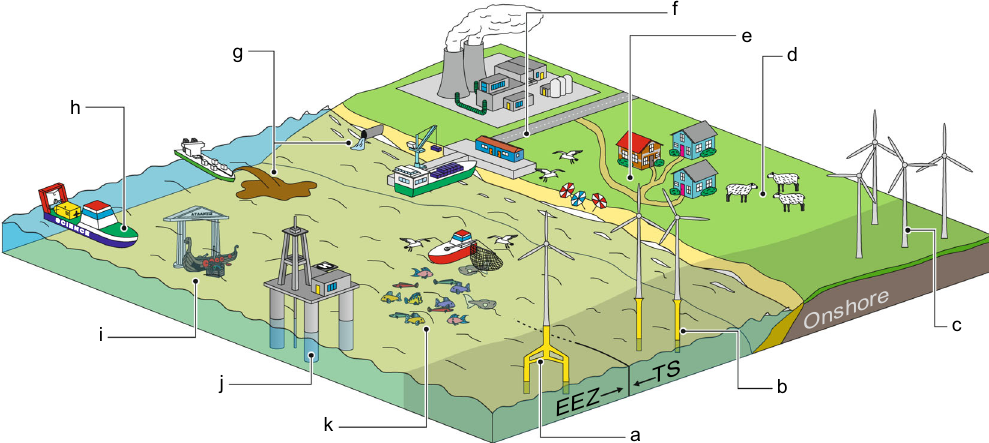
Fig. 1 Coastal environmental topics that were under consideration for the interdisciplinary group work. The dark-shaded area highlights the three different locations for wind farms, which are the commonly agreed research areas of the interdisciplinary group work. The three areas include a – c offshore within exclusive economic zone (EEZ), offshore within territorial sea (TS), and onshore near the coast. Alternative suggestions for research areas include d farming, e tourism and residential areas, f industry and infrastructure, g waste water disposal, dredging, and dumping, h scienti fi c surveys, i underwater cultural heritage, j marine resources, and k fi